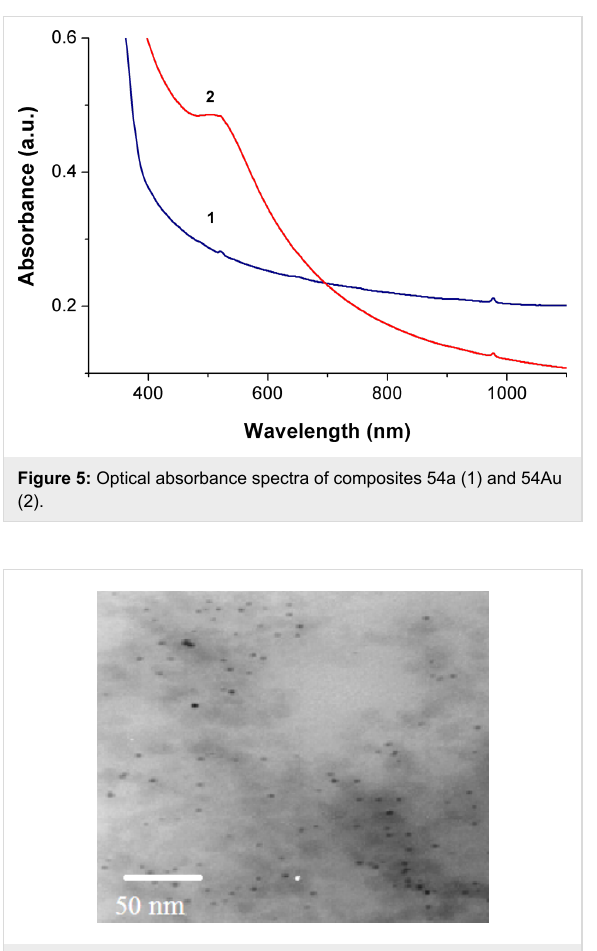
Figure 6: TEM pictures of the nanocomposite film REO-AuNPs- SiO 2 NPs-UDMA/IDA (52Au sample).